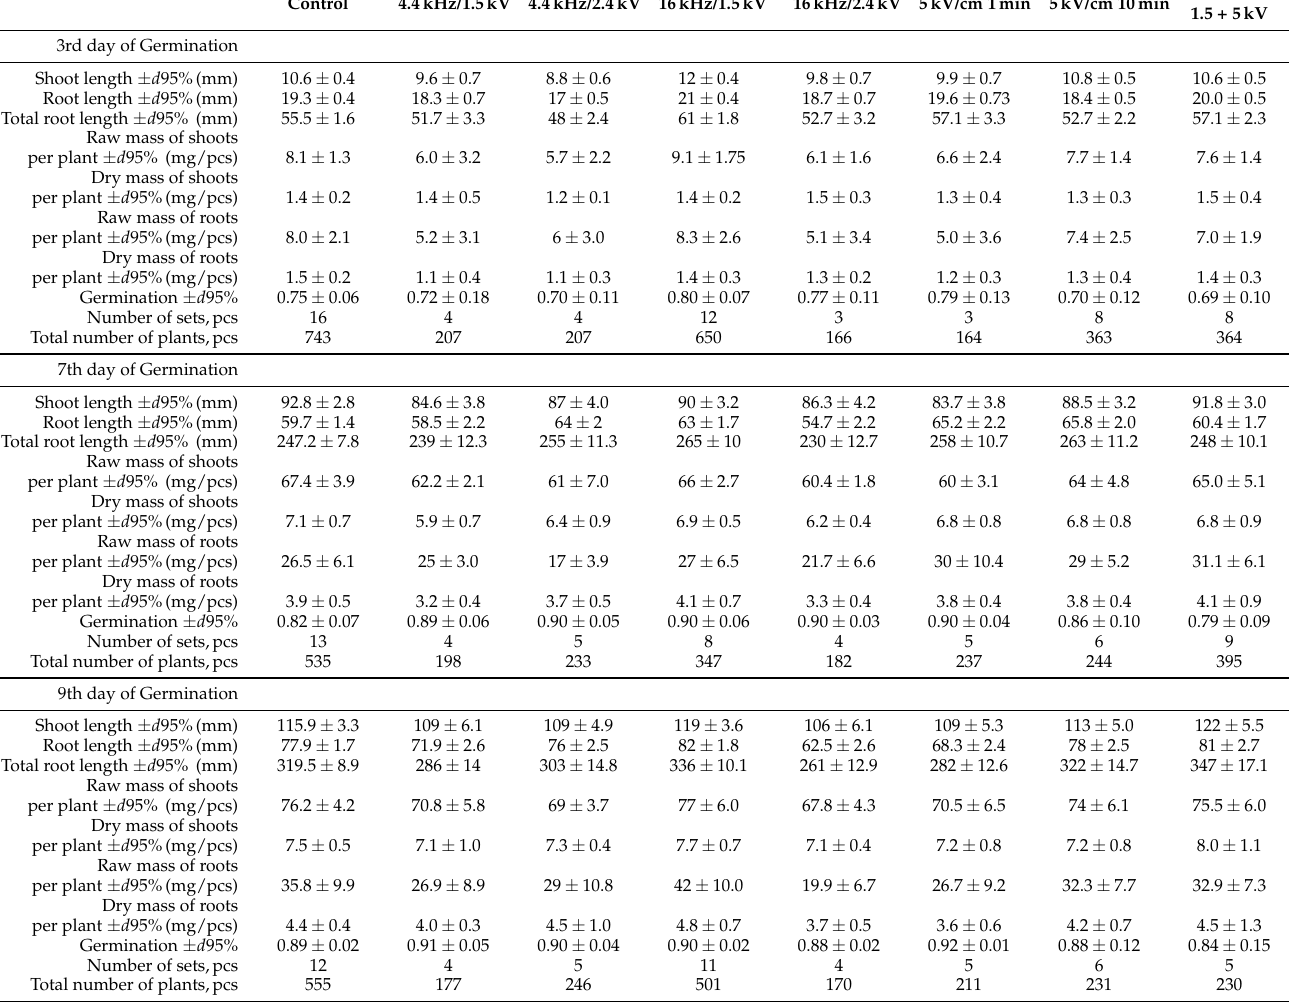
Table 2. Morphophysiological characteristics of seedlings on the 3rd, 7th, and 9th days of devel- opment after seed treatment with plasma and/or electric field. Control denotes variants without any treatment; 4.4kHz/1.5kV denotes variants treated by discharge at 1.5 kV and 4 kHz for 1 min; 4.4kHz/2.4kV by discharge at 2.4 kV and 4 kHz for 1 min; 16kHz/1.5kV denotes variants treated by discharge at 1.5 kV and 16 kHz for 1 min; 16kHz/2.4kV by discharge at 2.4 kV and 16 kHz for 1 min; 5kV/cm 1min treated by electric field of 5 kV/cm for 1 min; 5kV/cm 10min treated by electric field of 5 kV/cm for 10 min; and 16kHz/1.5kV +5kV denotes variants treated by discharge at 1.5 kV and 16 kHz with bias voltage of 5 kV for 1